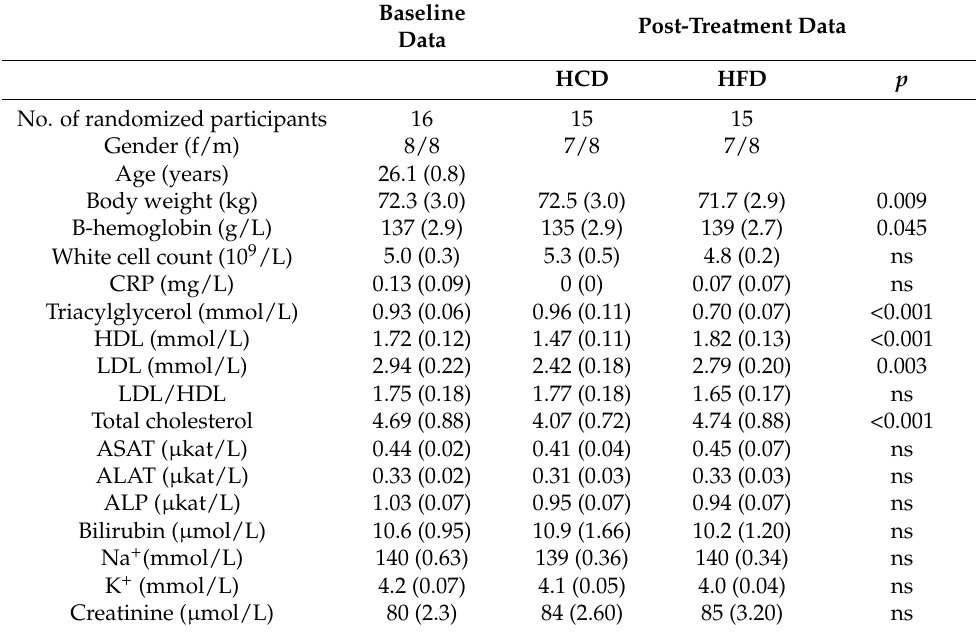
Table 2. Demographic and biochemistry